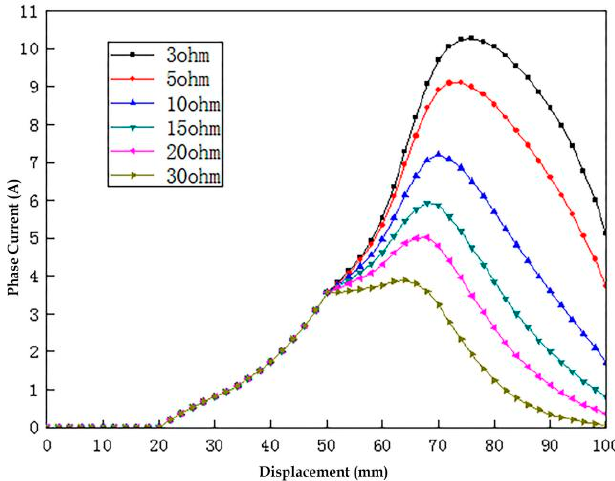
Figure 10. The phase current waveform under different loads is shown in Figure 10. Choosing different loads has certain influence on the phase current.